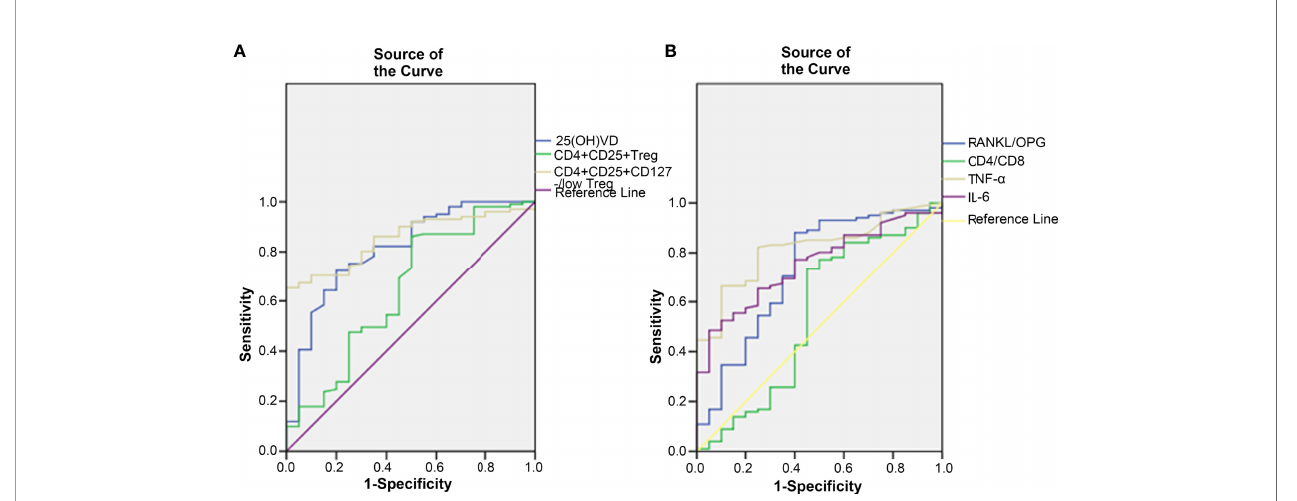
FIGURE 2 | The correlation between clinical indicators and the incidence of OP. (A) 25(OH)D, CD4 + CD25 + Treg cell and CD4 + CD25 + CD127 -/low Treg cell were found to decrease after the occurrence of OP. (B) RANKL/OPG, CD4/CD8, TNF- a and IL-6 were found to increase after the occurrence of